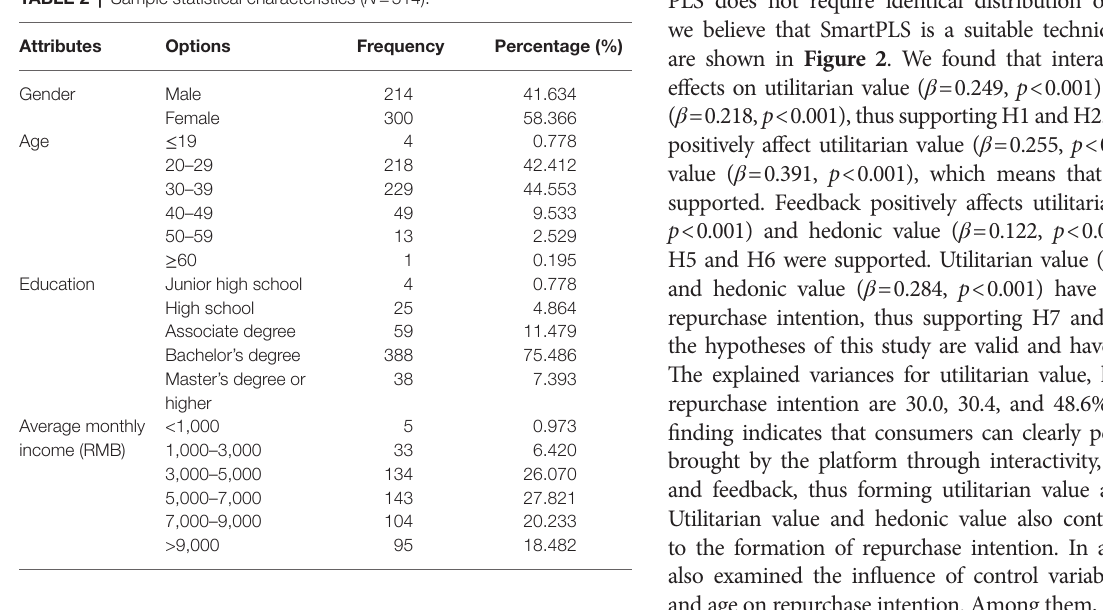
TABLE 2 | Sample statistical characteristics ( N =